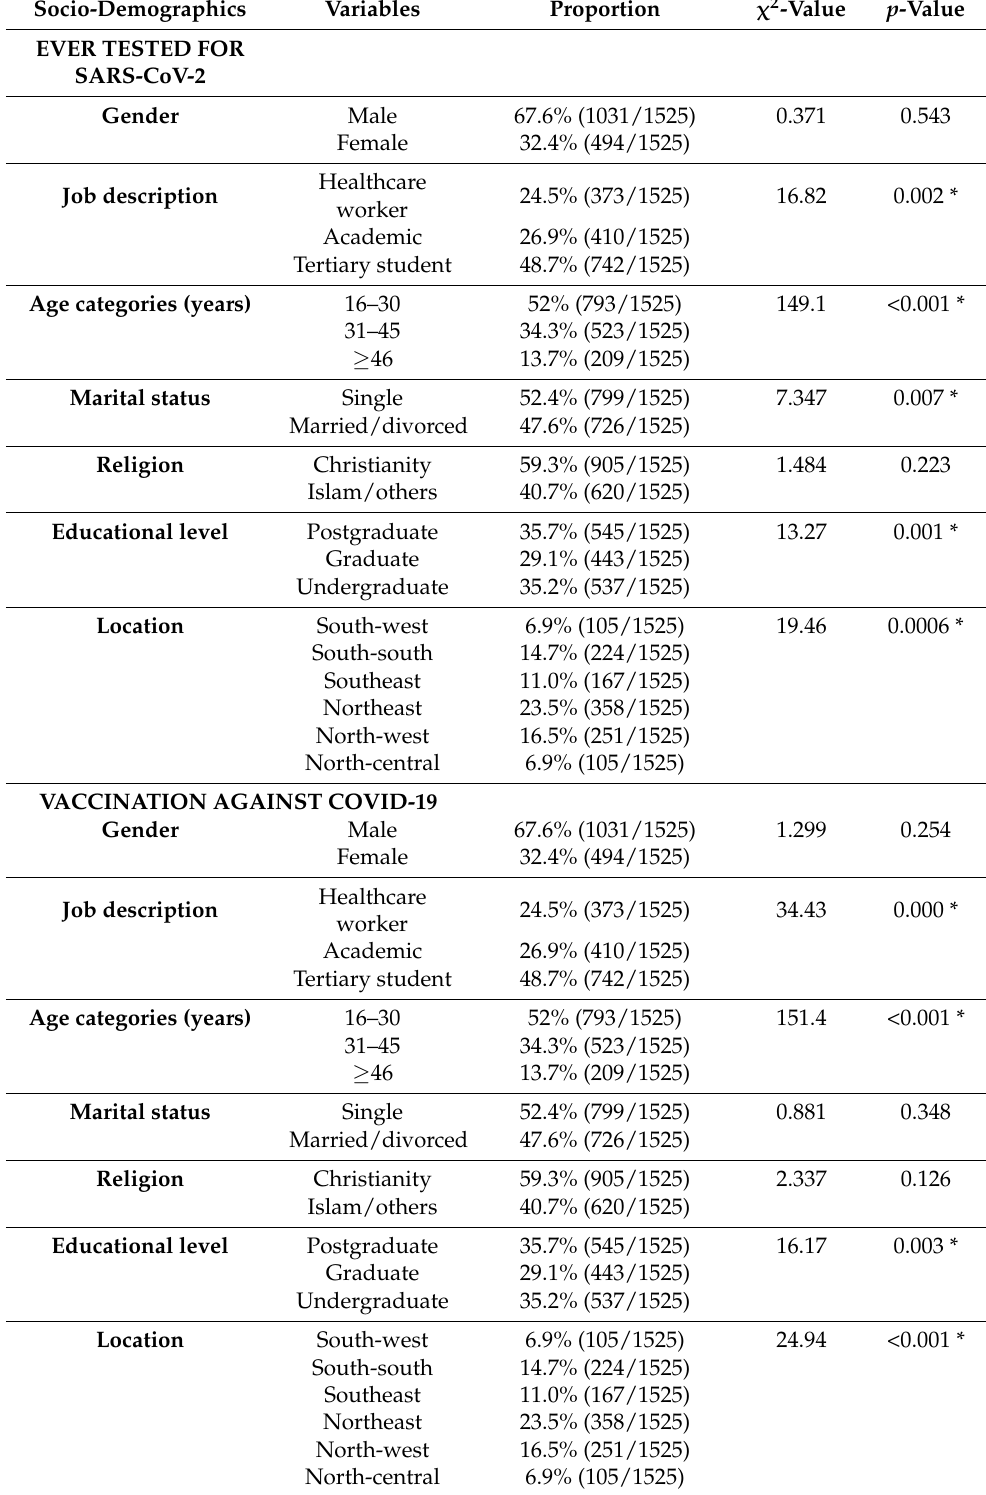
Table 1. Association between socio-demographics of respondents ( n = 1525) and testing for SARS- CoV-2 infections and COVID-19